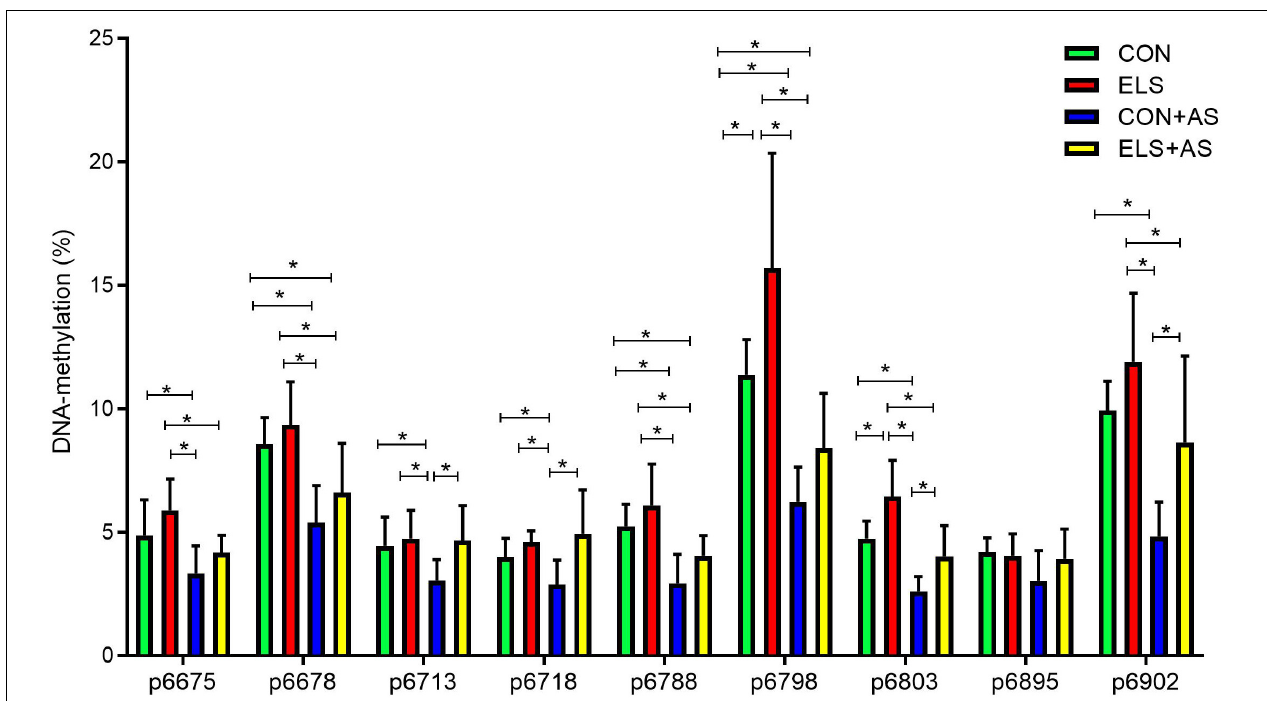
FIGURE 6 | Changes of DNA-methylation (%) at analyzed CpG sites within the Y2 receptor gene promoter in male animals. The locations of CpG-sites were determined according to their distance from the start codon. Significant results of the post hoc test (SNK) are represented as * p ≤ 0.05. CON, control; ELS, early life stress; CON+AS, control + adult stress; ELS+AS, early life stress + adult